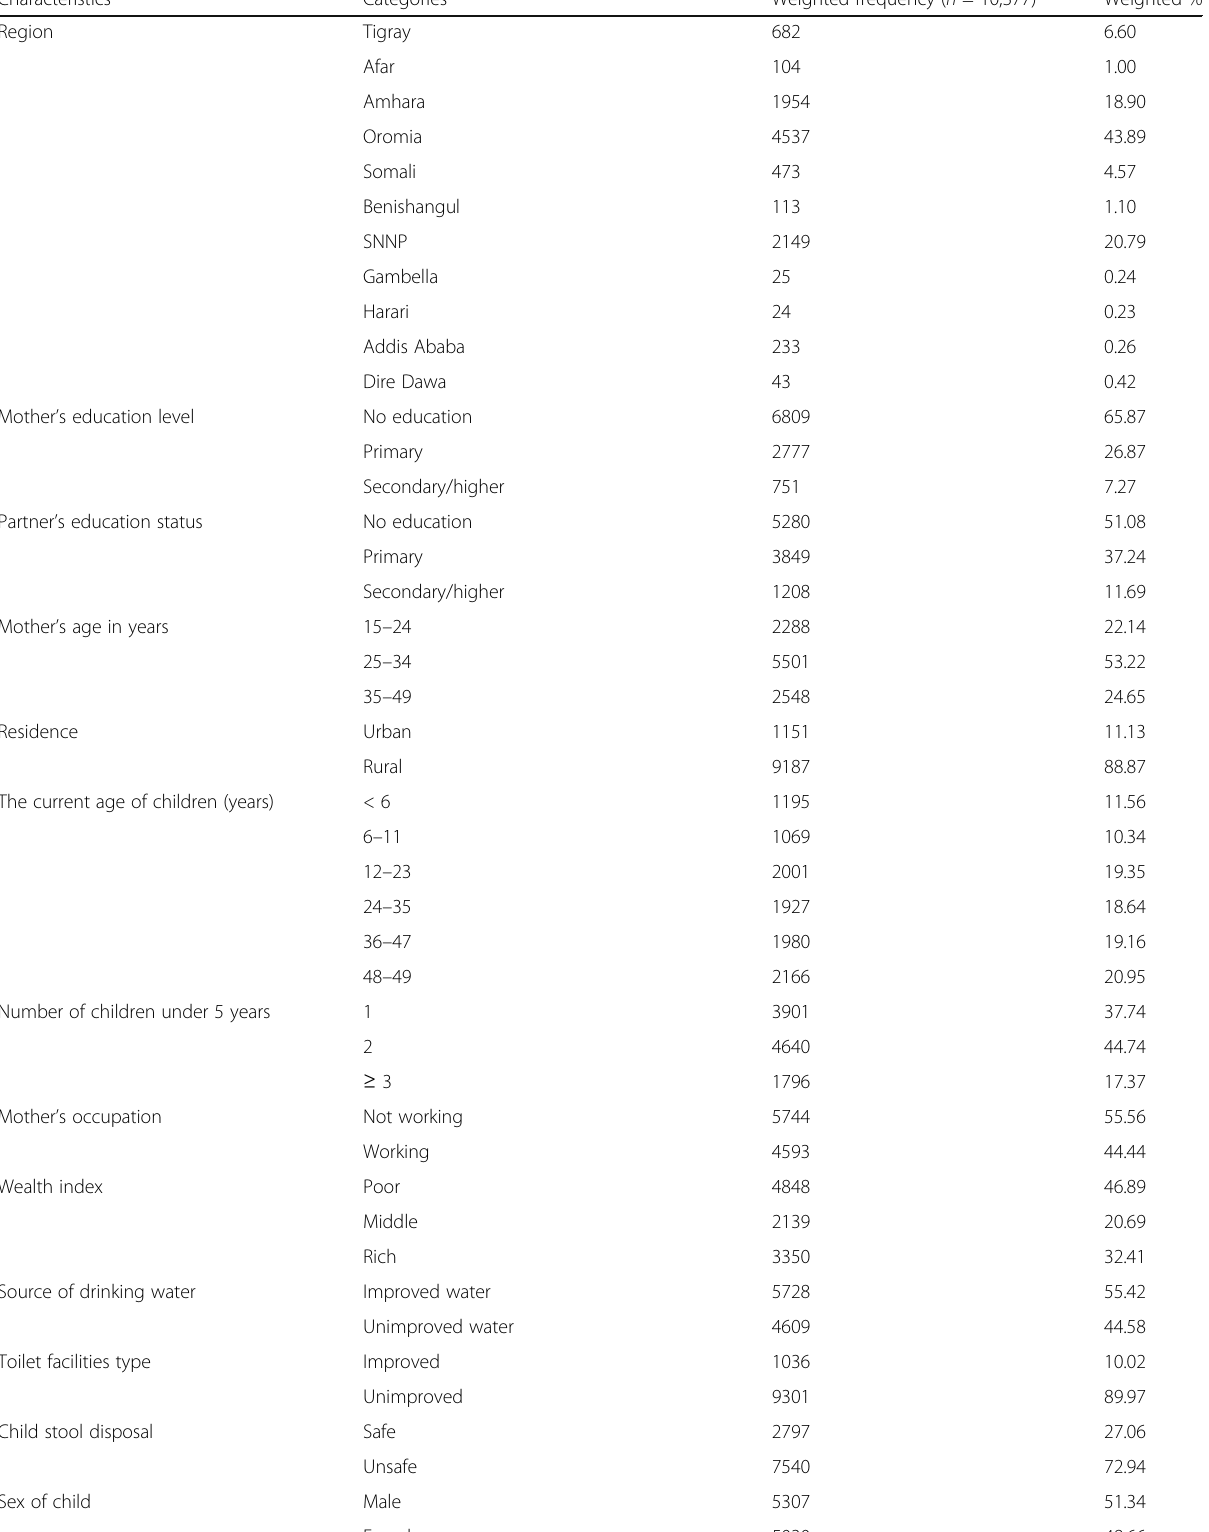
Table 1 Socio-demographic characteristics of mothers, parents, and children under 5 years of age, DHS 2016, Ethiopia